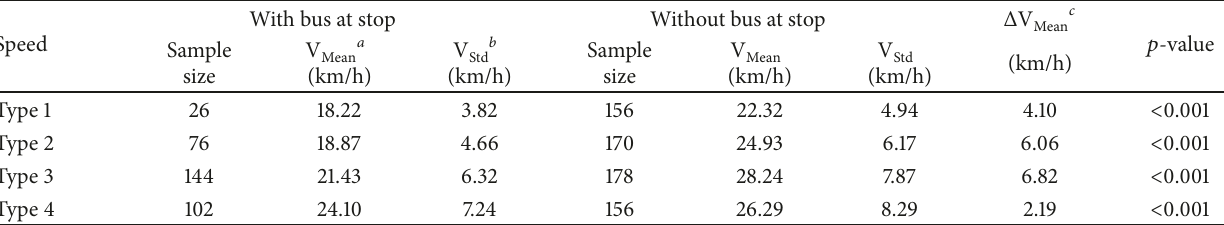
Table 3: Statistical tests for speed differences of all vehicles